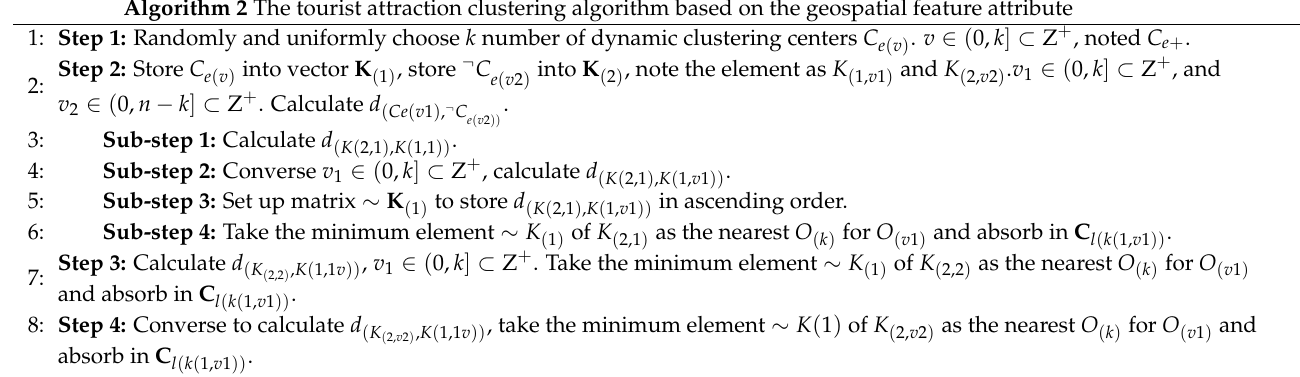
Algorithm 2 The tourist attraction clustering algorithm based on the geospatial feature